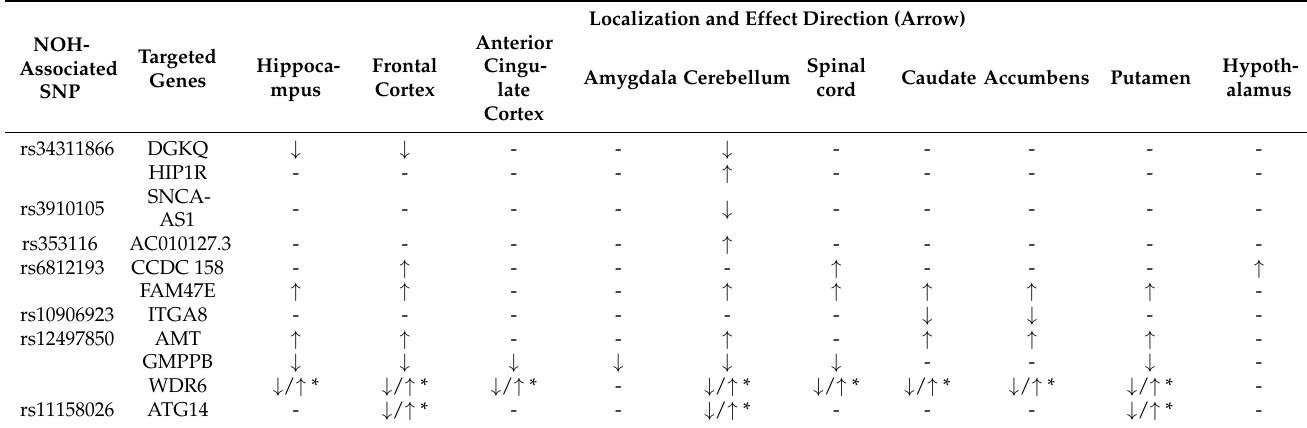
Table 5. Gene expression mapping based on linkage disequilibrium analysis and eQTL.